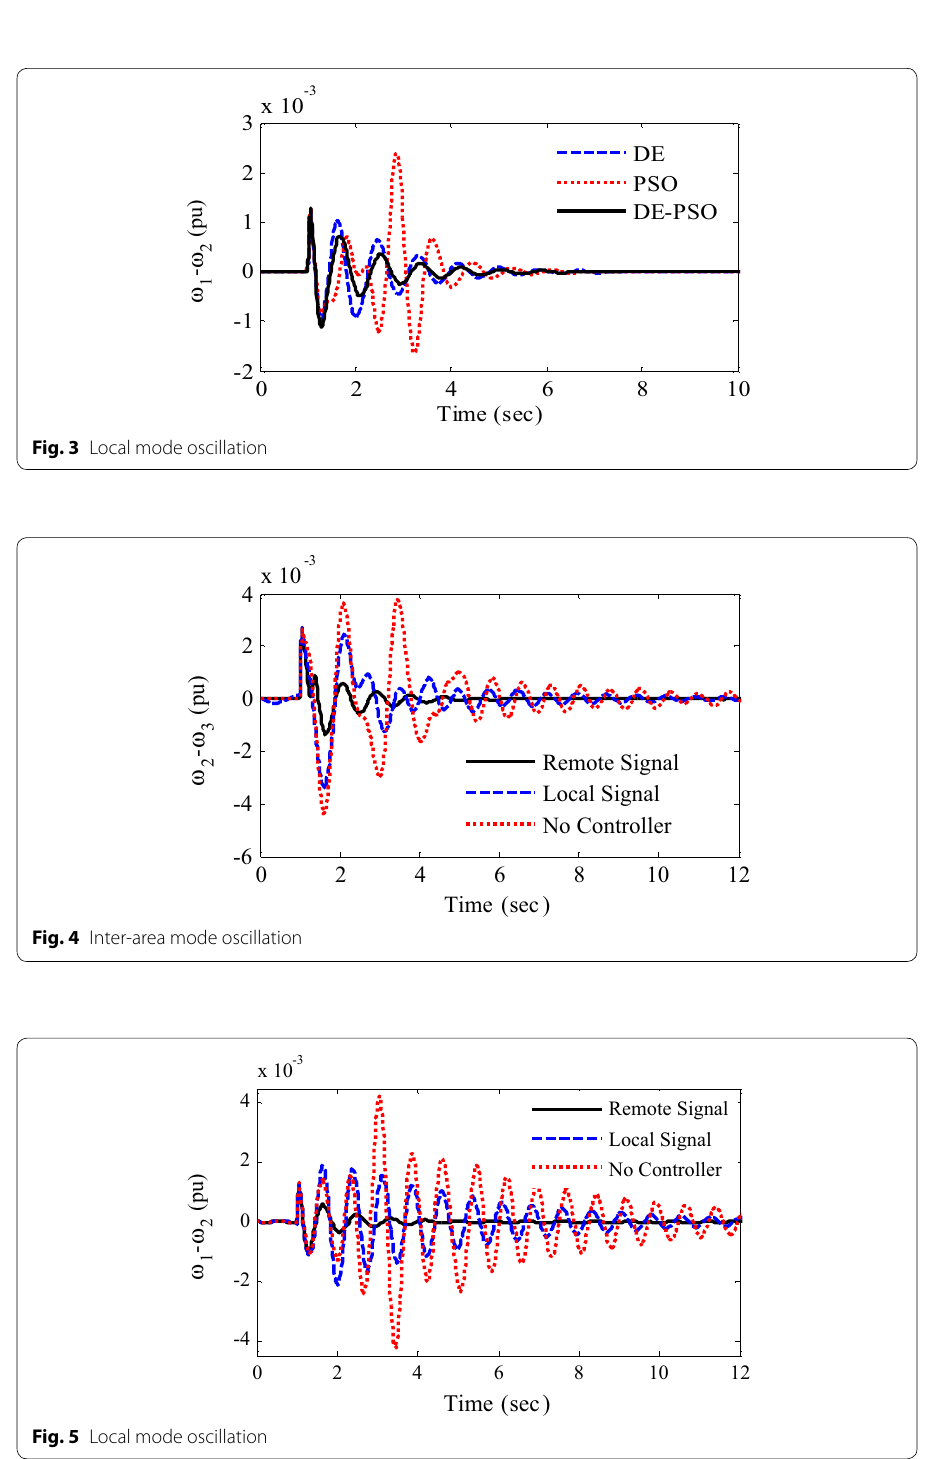
remote signal. The response of the system with no controller is shown with dotted line (with legend NC); response with local signal is shown with dashed line (with legend local signal); and response with remote signal is shown with solid line (with